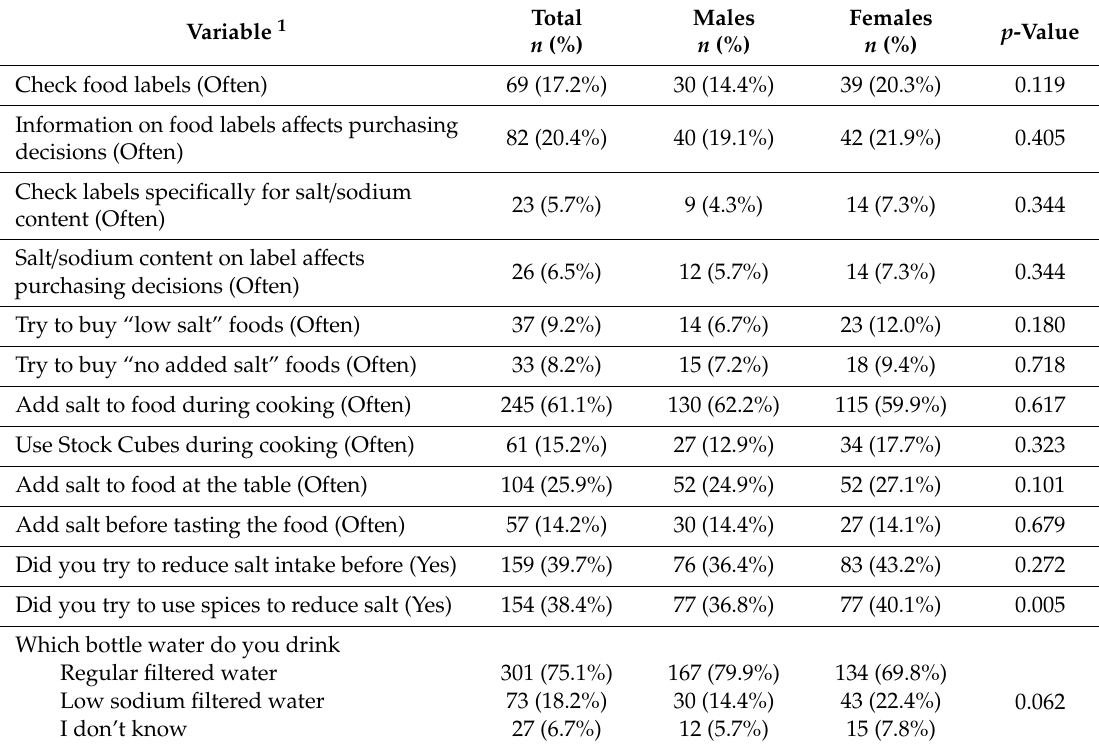
Table 4. Salt-related practices among UOS students ( n = 401) by